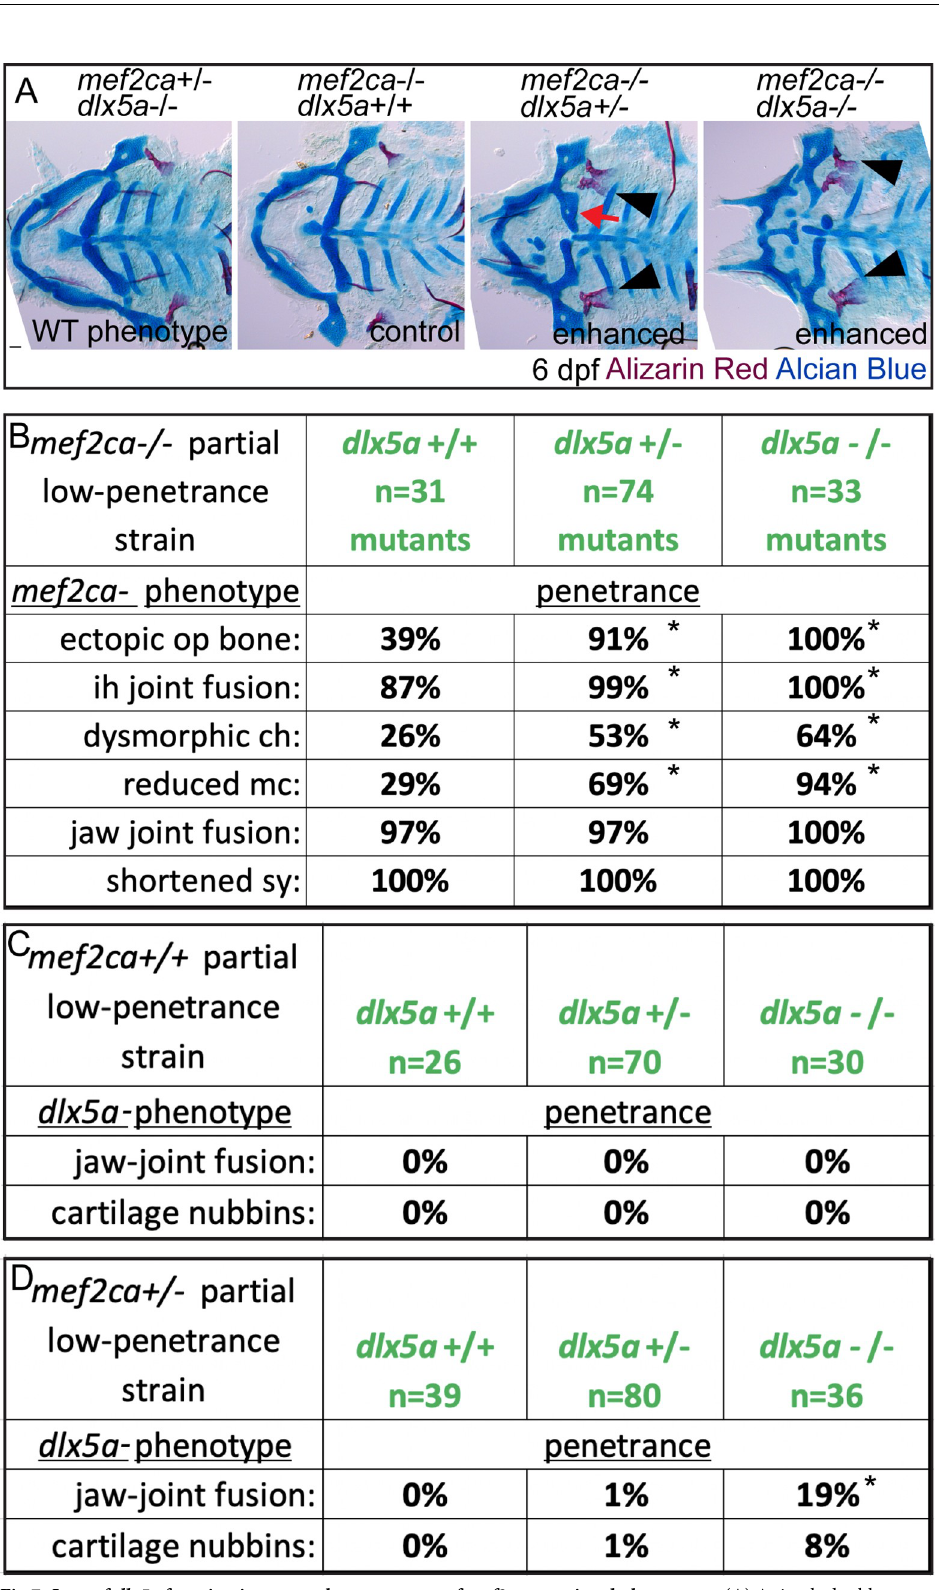
Fig 7. Loss of dlx5a function increases the penetrance of mef2ca -associated phenotypes. (A) Animals double heterozygous for mef2ca and dlx5a were intercrossed, raised to 6 dpf and fixed and stained with Alcian Blue